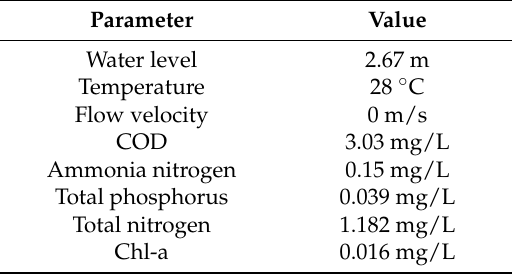
Table A1. Initialization of